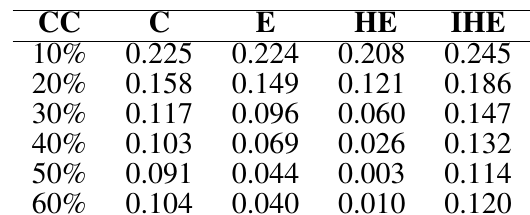
Figure 7. Reflectance changes with different CC in case of canopy shape is ellipsoid. The reflectance decreased from 10% Table 2. The difference between the shadow fraction estimated to 40%, but there was no significant change in reflectance from the voxel model and virtual forest at the same sun position. between 40% and 60%. The average shadow fraction, calculated using the voxel model, is 0.27.